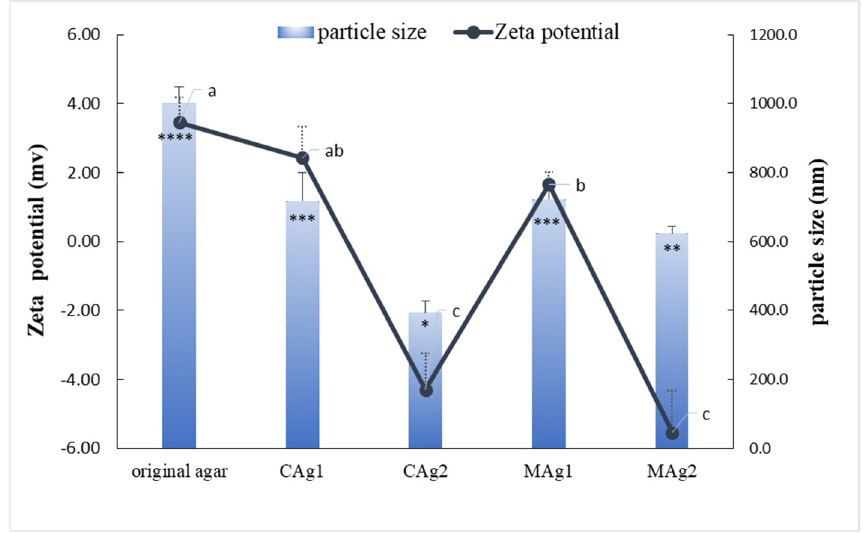
Figure 3. Effect of the synthetic method on zeta potential and particle size of unmodified and modified agar. Note: Different letters on the line and different number of symbols (*) above the columns indicate significant differences ( p < 0.05).